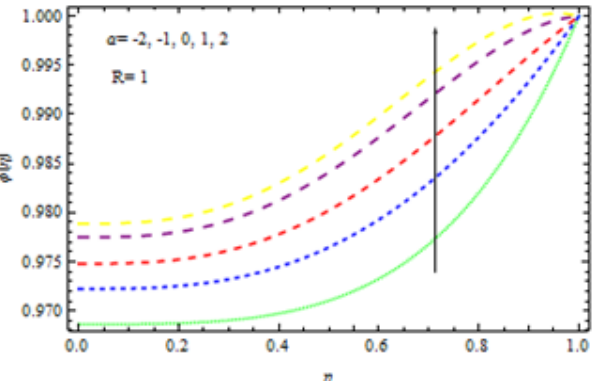
Figure 19. Influence of 𝛼 on concentration.